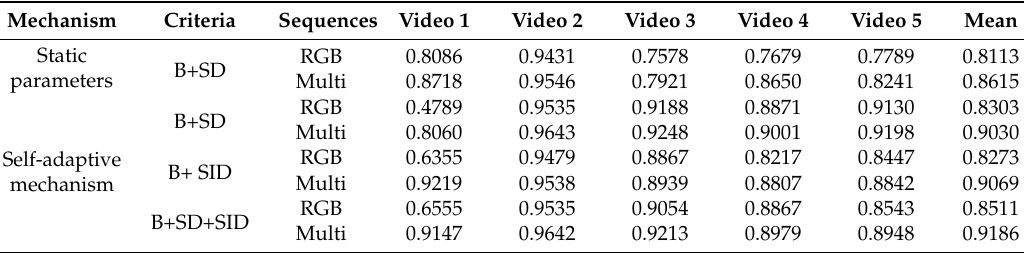
Table 5. Best F-measures with different mechanisms and sets of criteria on the five